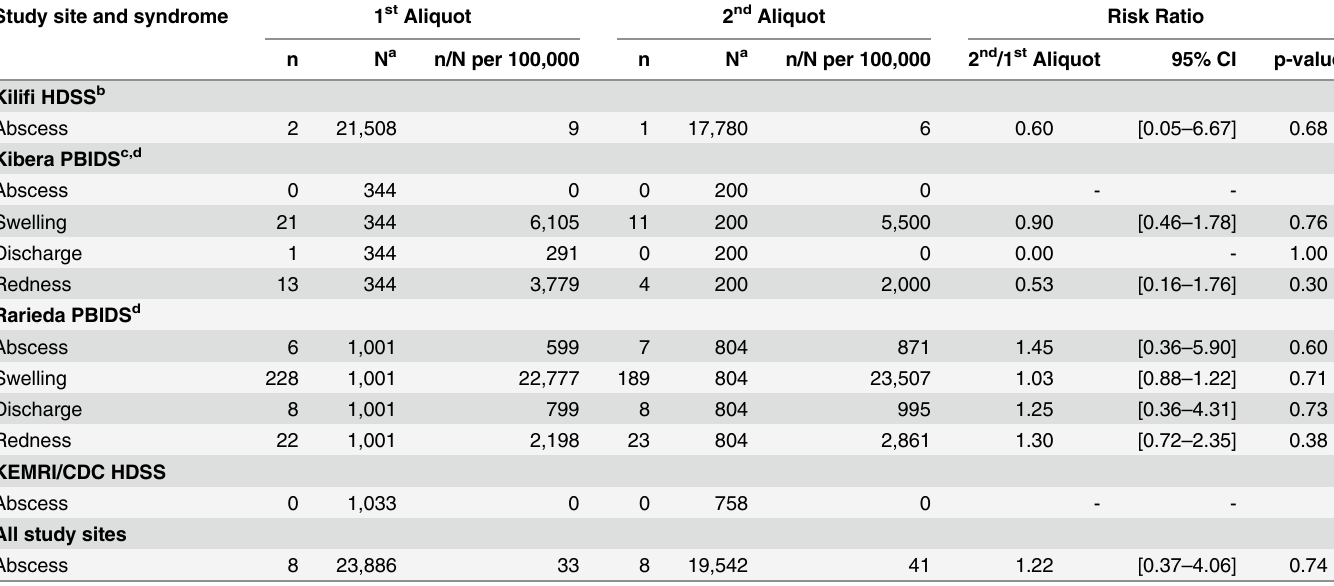
Abbreviations: CDC, Centers for Disease Control and Prevention; CI, con fi dence interval; HDSS, Health and Demographic Surveillance System; PBIDS, Population-based Infectious Disease Surveillance Site; KEMRI, Kenya Medical Research Institute; VAEIK, Vaccine Adverse Events in Kenya a Denominator is the number of vaccine doses administered.